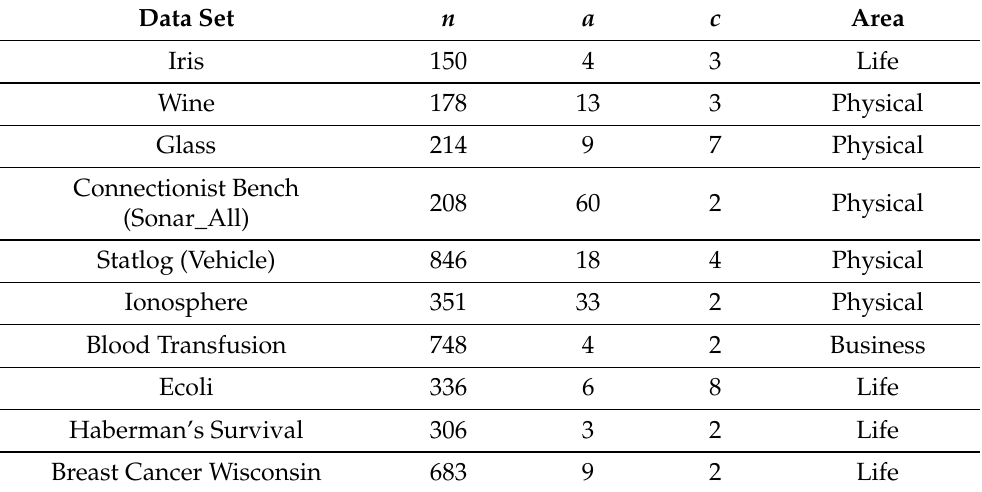
Table 2. Summary of Data